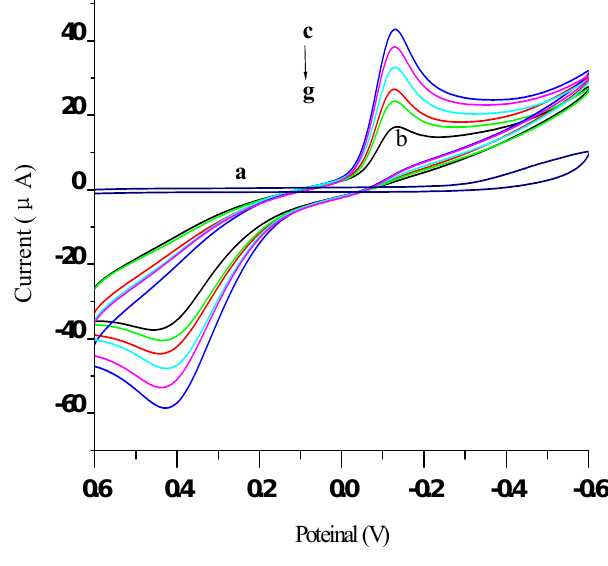
Figure 5. CVs of different modified electrodes measured in: ( a ) 0.01 mol/L PBS containing 0.1 mol/L KCl (pH 7.4); when added 5 mmol/L HQ: ( b ) Bare GE; ( c ) AuNPs/GE; ( d ) Thiolated protein G/AuNPs/GE; ( e ) AFP Ab1/thiolated protein G/AuNPs/GE; ( f ) BSA/AFP Ab1/thiolated protein G/AuNPs/GE; ( g ) AFP antigen/AFP Ab1/thiolated protein